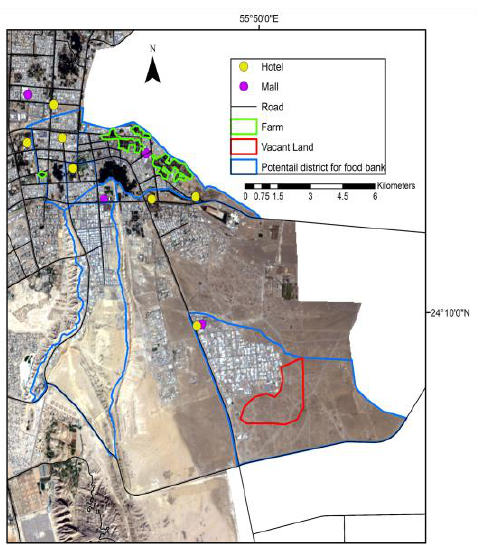
Figure 2. Elevation at the potential districts for food banks.